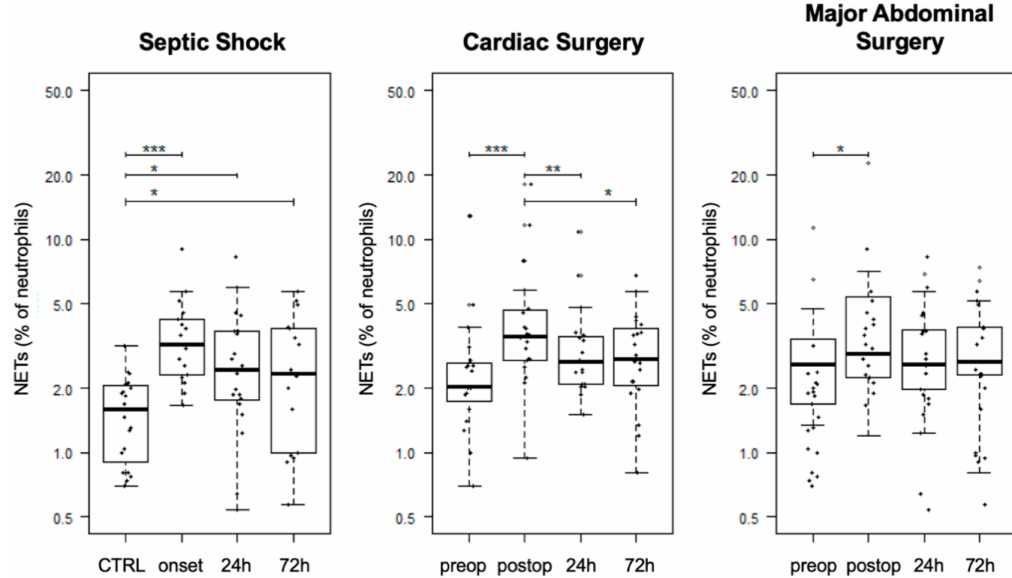
Figure 3. Time courses of free-circulating NETs. Results are shown in boxplot diagrams. Asterisks display the degree of statistical significance: *: p < 0.05; **: p < 0.01; ***: p < 0.001. Abbreviations: CTRL: Control group; NETs: Neutrophil Extracellular